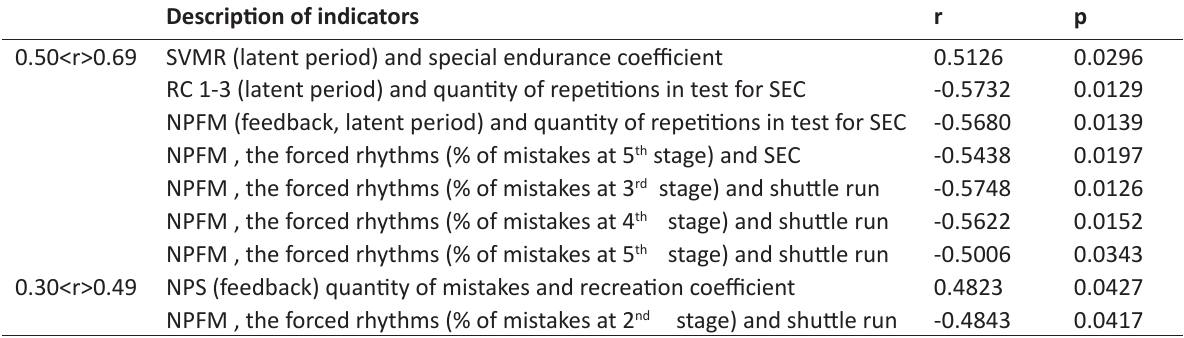
Table 3. Correlations between pedagogic testing results and wrestlers’ psycho-physiological indicators Description of indicators r p